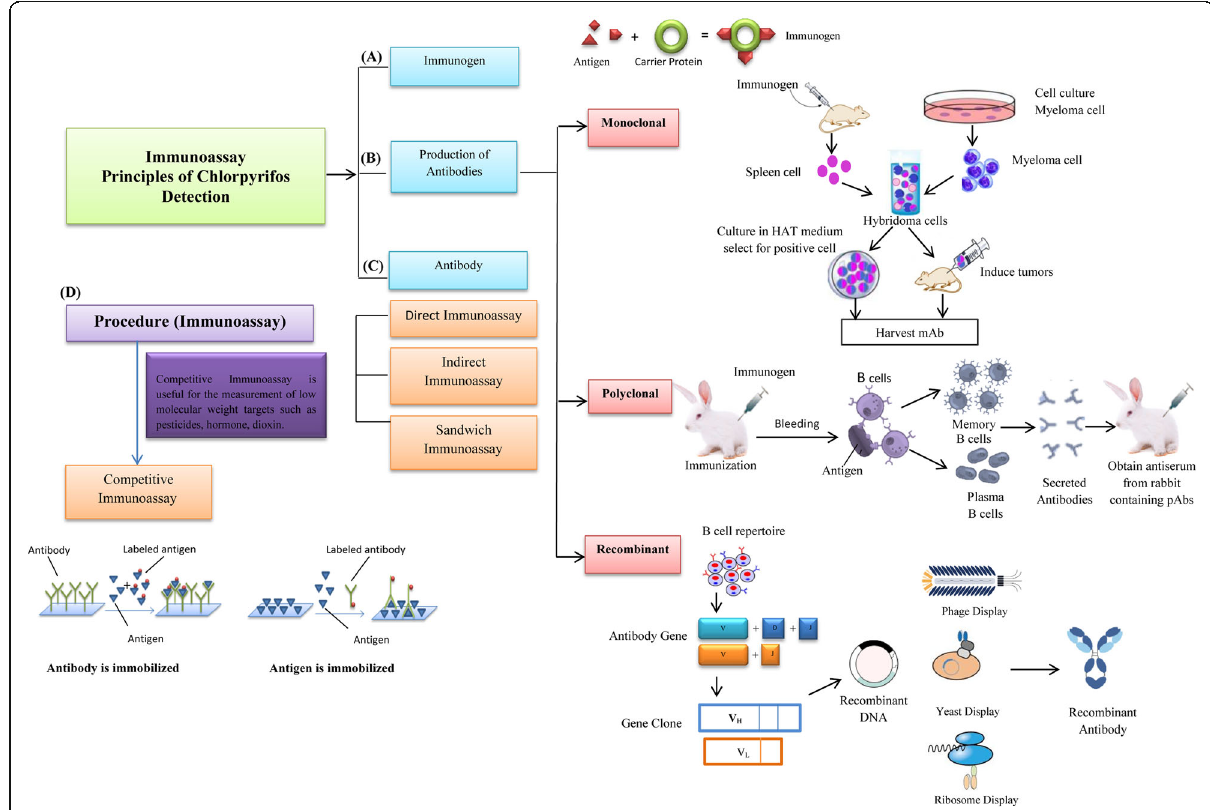
Fig. 4 A Small molecules can be recognized by antibody but cannot stimulate the immune system to produce antibody. B They must conjugate with carrier protein to form an immunogen for production of a monoclonal, polyclonal, and recombinant antibodies. C The antibody is a Y- shaped molecule composed of four polypeptide subunits with two identical heavy and light chains. D Type of immunoassay used for CPF